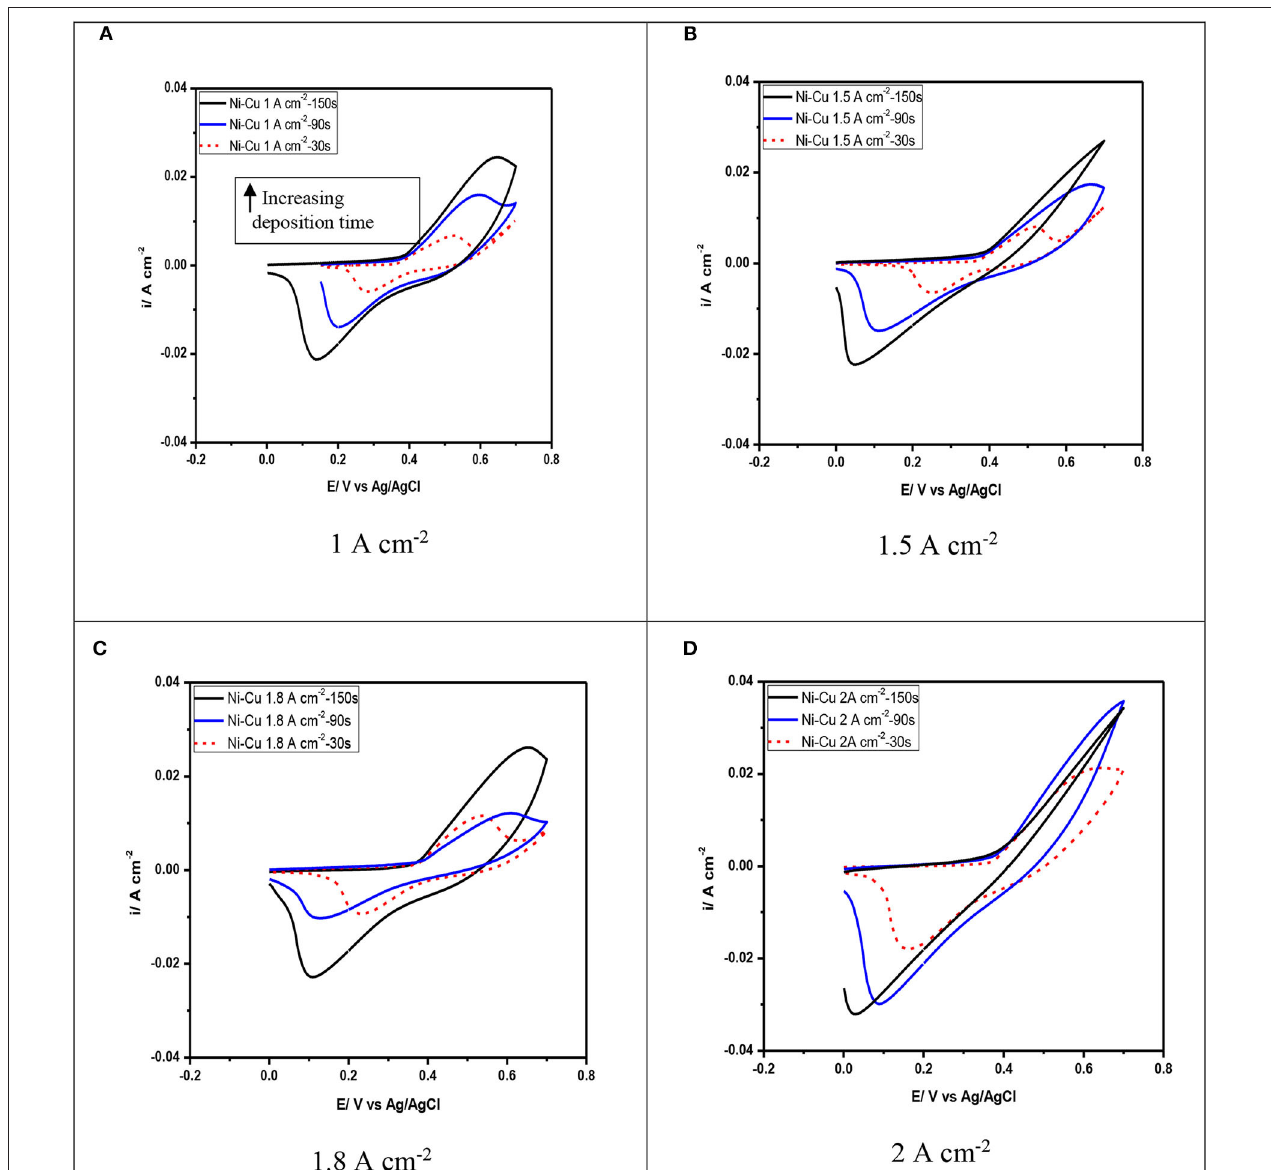
FIGURE 9 | Cyclic voltammetry of Ni–Cu foams tested in 1M KOH solution at scan rate 75 mV/s. (A) 1A cm − 2 , (B) 1.5A cm − 2 , (C) 1.8A cm − 2 , (D) 2A cm − 2 .